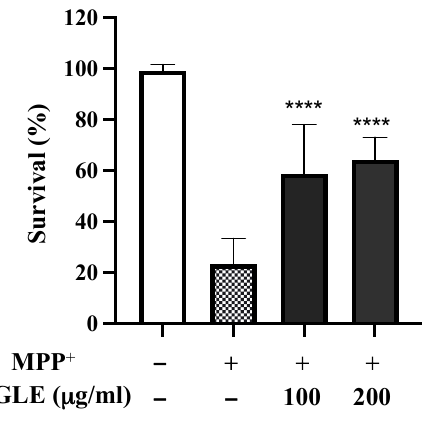
Figure 2. Effect of GLE on 1-methyl-4-phenylpyridinium ion (MPP + )-induced neurotoxicity in N2 C. elegans. The effects of GLE (100 and 200 µg/mL) on MPP + -induced toxicity were evaluated. Experiments were performed in triplicate. Data are presented as mean ± SD. **** p < 0.0001 compared to MPP + -treated worms.